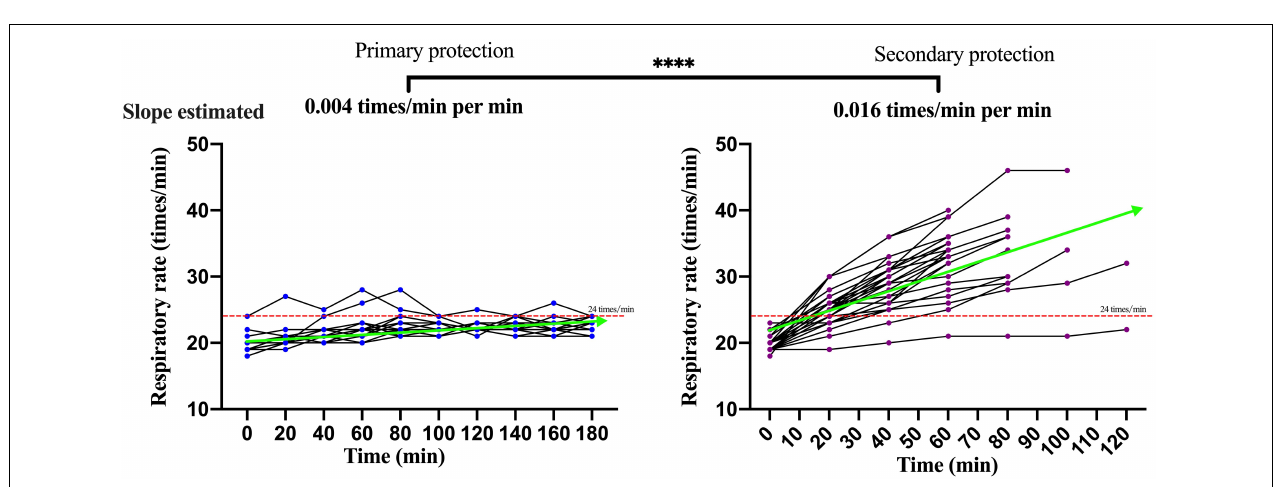
FIGURE 5 | The dynamics of respiratory rate of participants with primary and secondary PPE. ∗∗∗∗ p < 0.0001. The slopes of respiratory rate during the trial were calculated by generalized estimating equations. PPE | personal protective